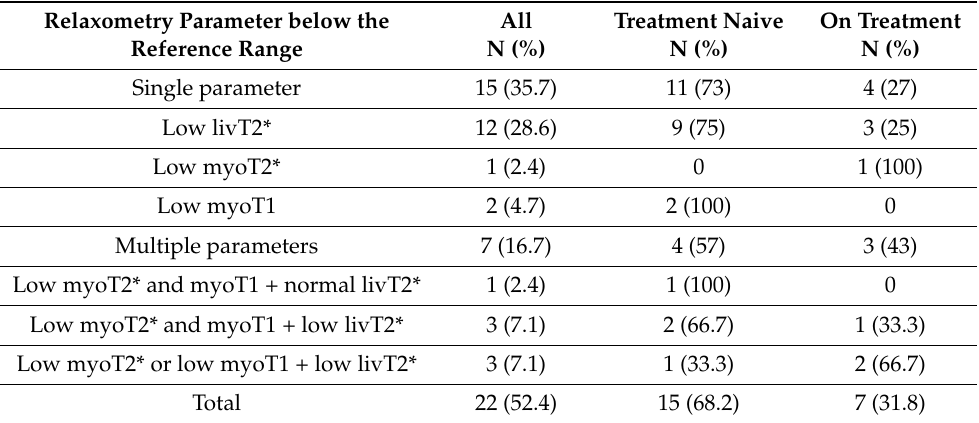
Figure 1. ( A – D ) Inline T1 and T2* maps generated with MyoMaps (Siemens Healthineers, Erlangen, Germany) showing myocardial T2* and myocardial T1 maps in healthy control (( A ) average T2* = 35 ms, and ( B ) average T1 = 962 ms) and in an HCH patient with reduced myocardial T2* and normal T1 relaxation times (( C ) average T2* = 23 ms, and ( D ) average T1 = 988 ms). The institutional reference ranges of T1 and T2* were 993 ± 21 ms [951–1035 ms] and 36.5 ± 3.8 ms [29–44 ms], respectively. ( E ) An example of ROI placement for liver T2* measurement in a hemochromatosis patient using the cardiac T2* mapping sequence (average liver T2* in the three ROIs shown in the right panel was 14.9 ms, which corresponds to 1.67 mg [Fe] per gram dry weight). This map was generated with cvi42 (Circle Cardiovascular Imaging, Calgary, Canada). MOLLI, modified Look-Locker inversion recovery; SAX, short axis. Table 4. The prevalence of abnormally low relaxometry parameters (myoT2*, myoT1, and/or livT2*) in the study group. Abbreviations as in Table Table 3. Relaxometry parameters in the study group. Data are presented as median (25th–75th per-